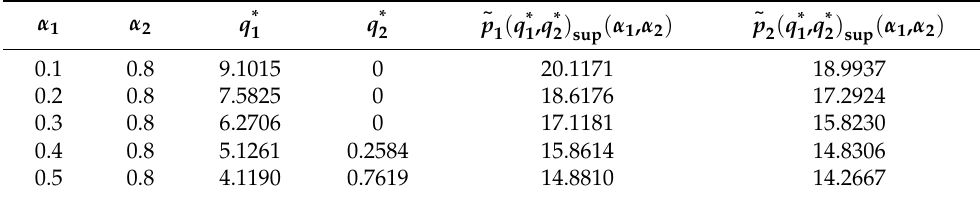
( α 1 , α 2 )-optimistic equilibrium quantity for Scenario II when CDT’s risk aversion levels increase.